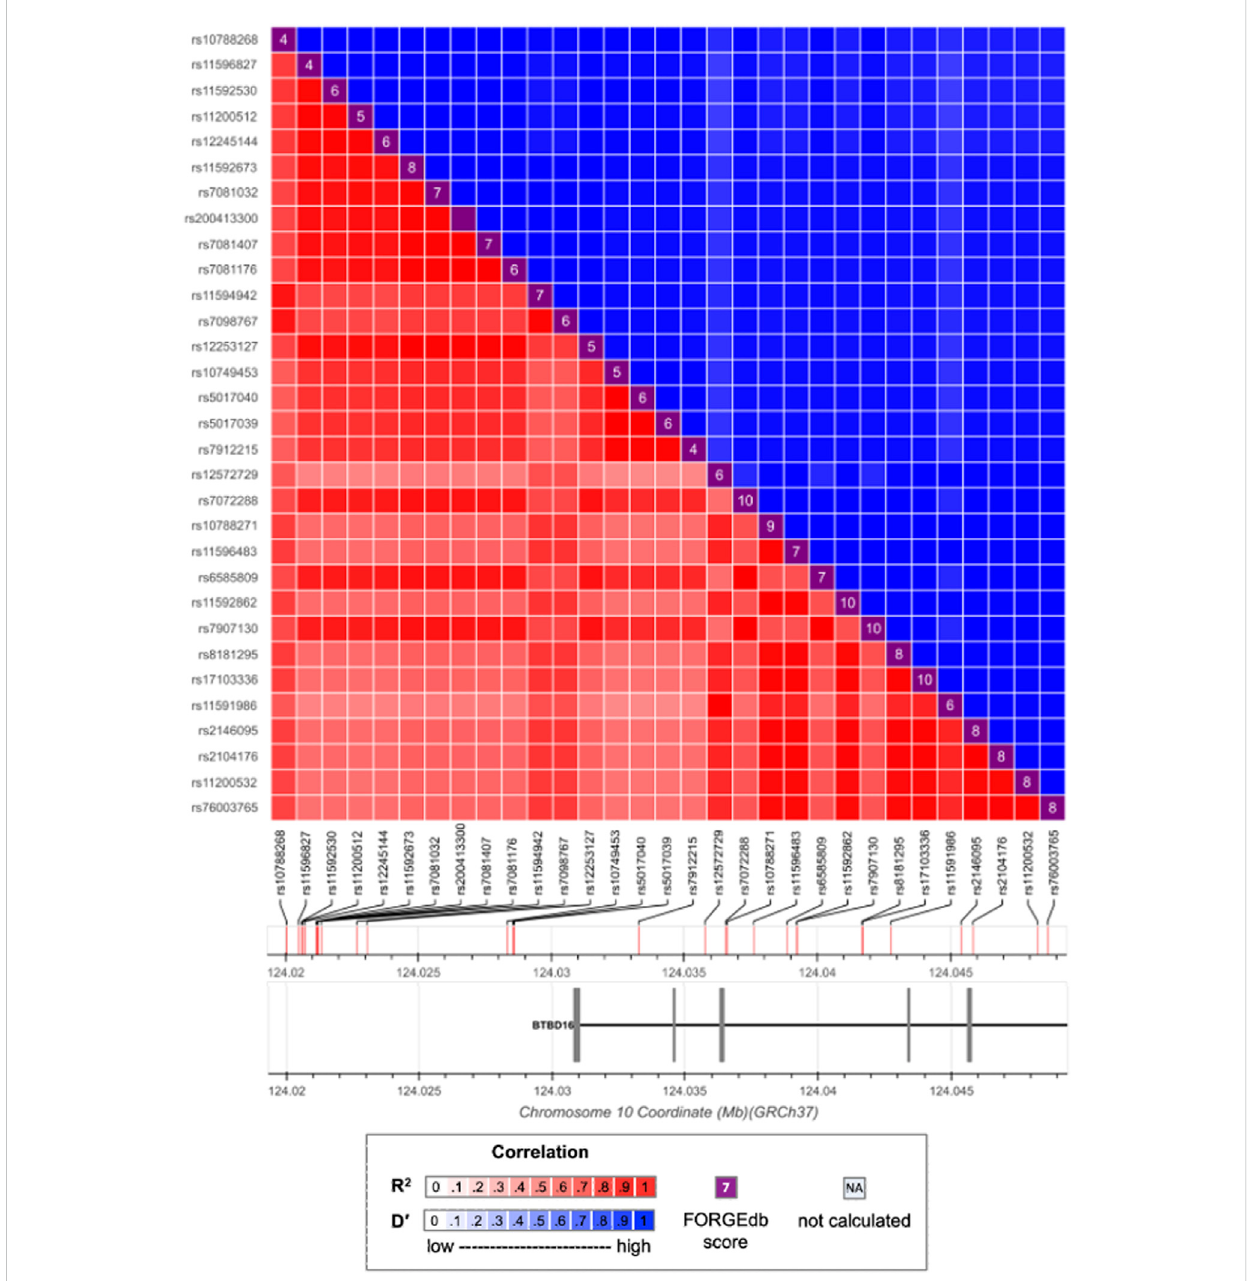
FIGURE 1 LD pattern between strong and weak SNPs. Marginally strong SNPs: rs57581057, rs10788268, rs11594942, rs7098767, rs12572729, rs10788271, rs11596483, rs8181295, rs17103336, rs11591986, rs2146095, rs2104176, rs11200532, rs76003765. Marginally weak SNP: